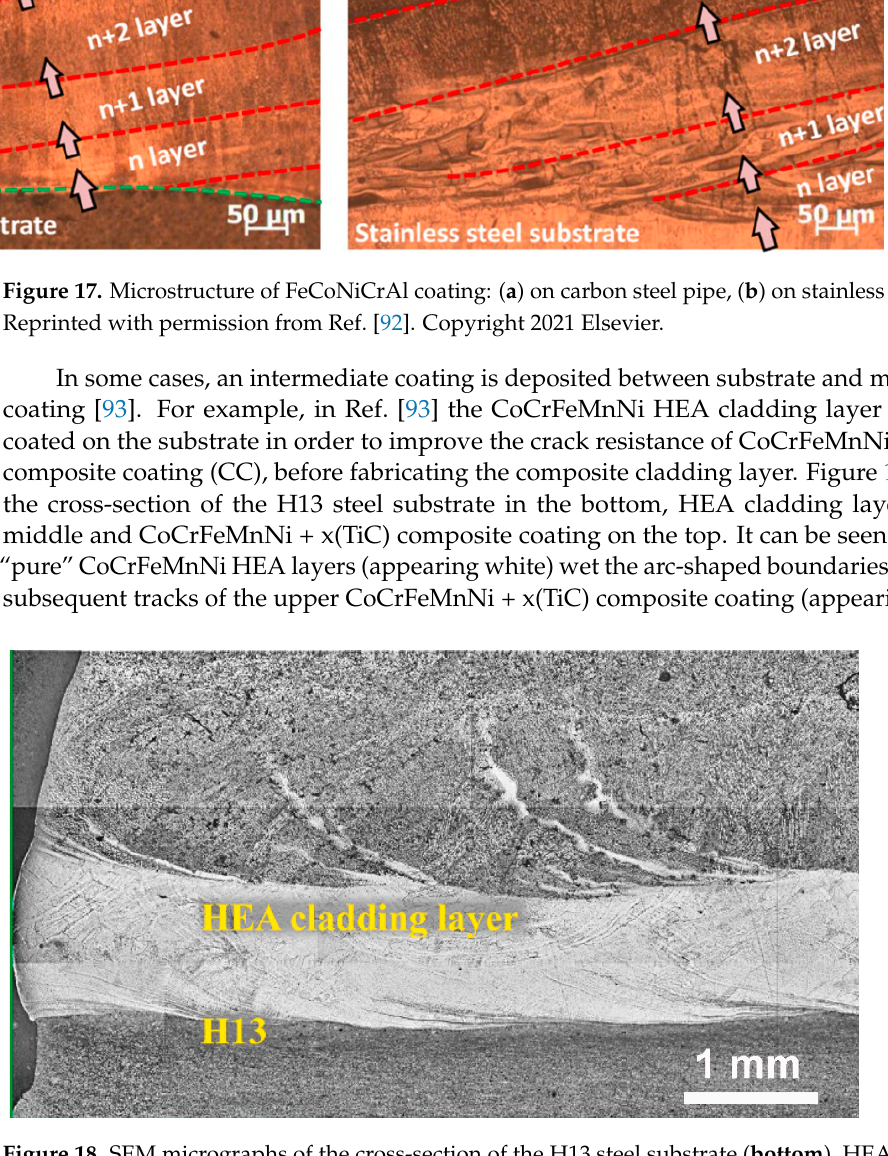
Figure 18. SEM micrographs of the cross-section of the H13 steel substrate ( bottom ), HEA cladding layer ( middle ) and CoCrFeMnNi + x(TiC) composite coating ( top ). Reprinted with permission from Ref. [93]. Copyright 2021 Elsevier.